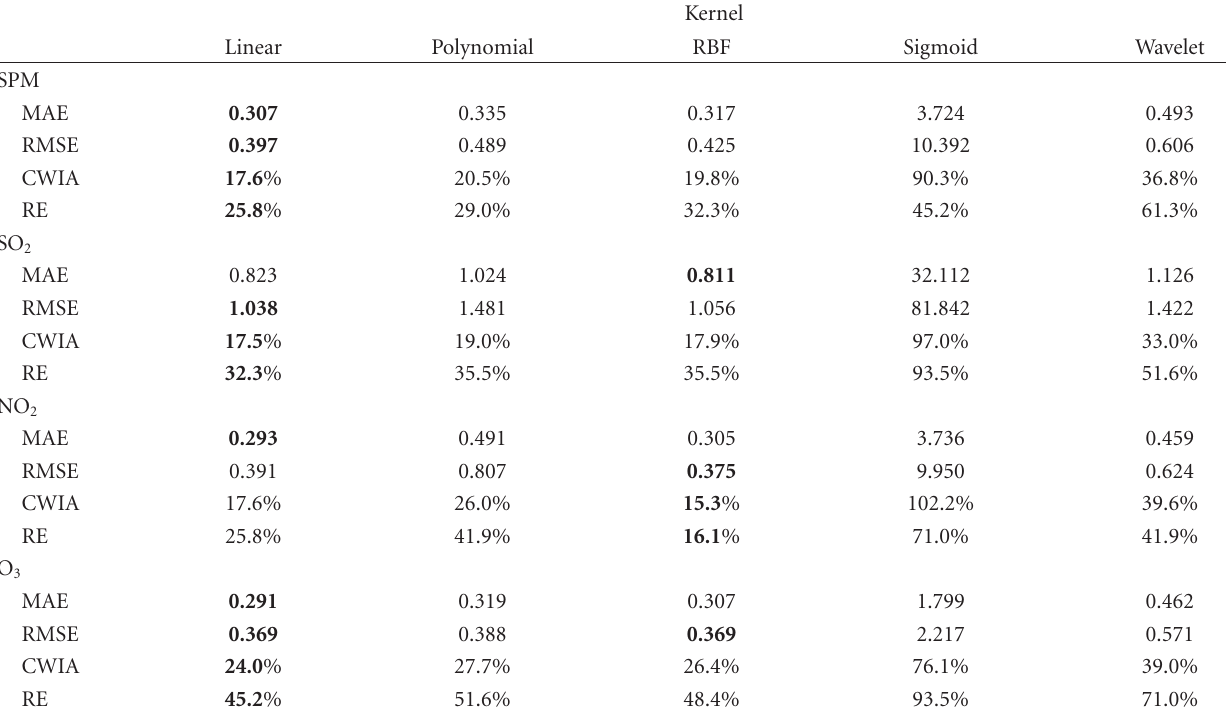
Table 5: The tested results of SPM, SO 2 , NO 2 , and O 3 in di ff erent kernel models in winter experiment.